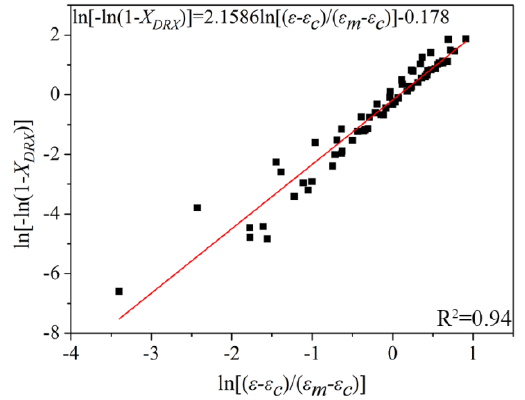
Figure 7. Schematic of ln [ - ln(1 - X DRX ) ] versus ln ( ε - ε c